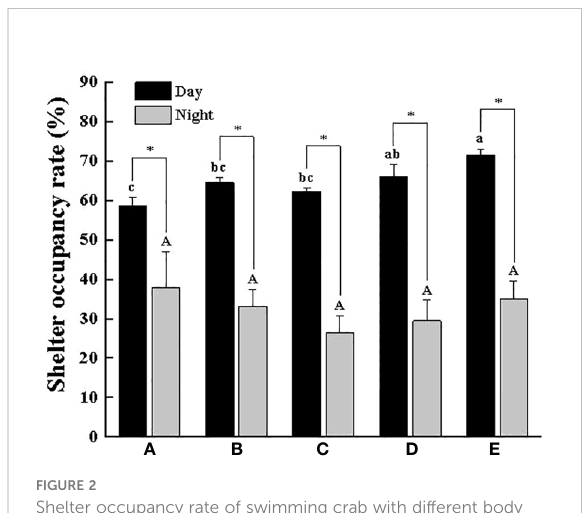
FIGURE 2 Shelter occupancy rate of swimming crab with different body weight groups in the presence of shelters. Different letters indicate signi fi cant differences among different body weight groups ( P < 0.05) and “ * ” indicates signi fi cant differences between day and night ( P <